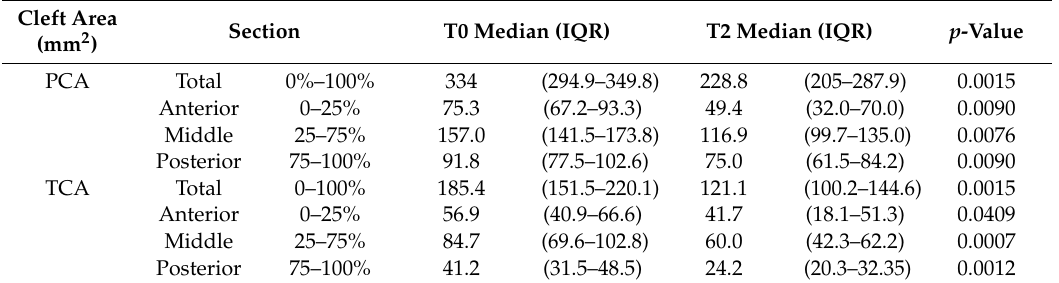
Table 3. Measured changes in palatal cleft area (PCA) and true cleft area (TCA).